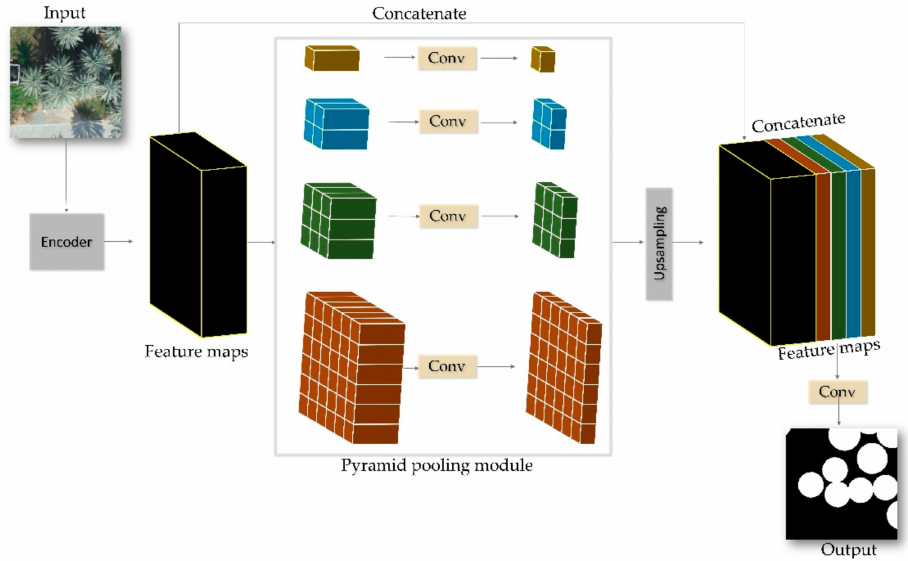
Figure 5. PSPNet